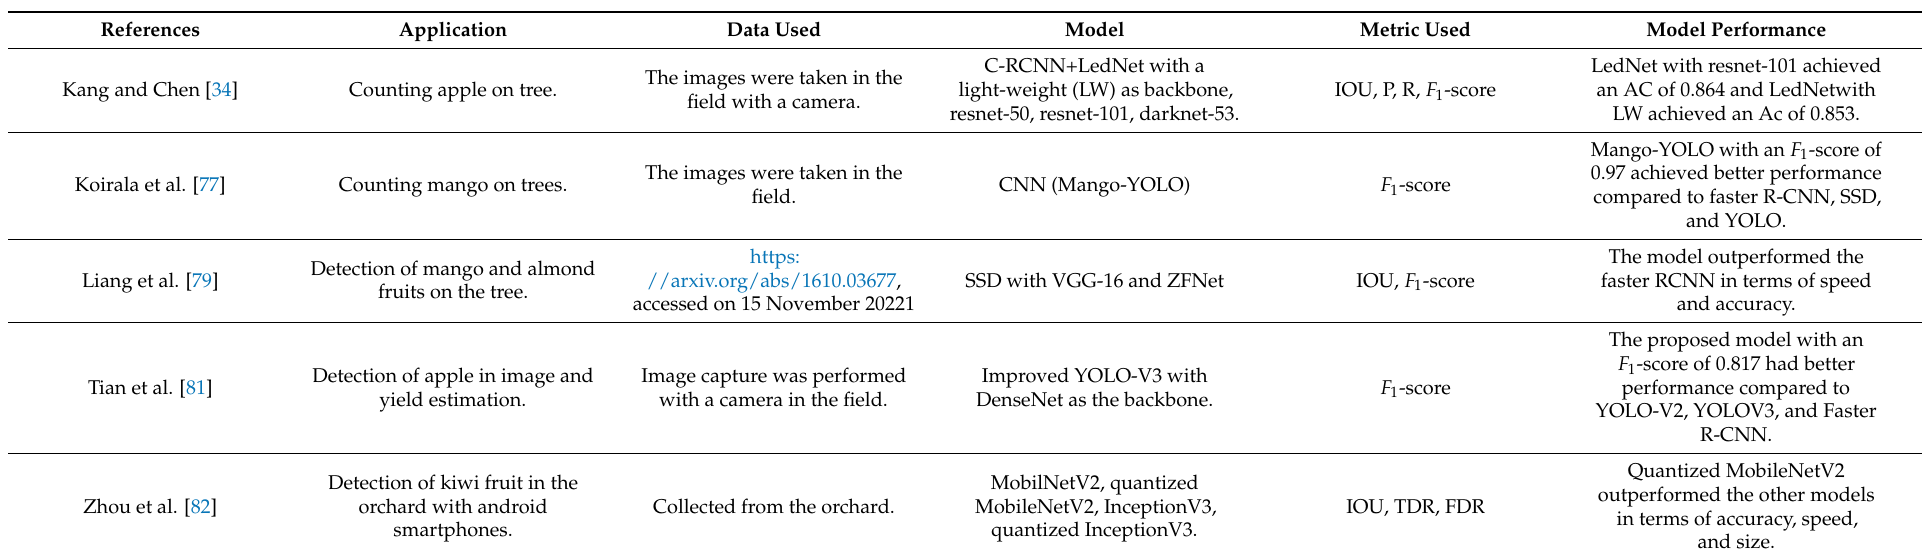
Table 4. Feature descriptions of recent published papers in the field of “Fruit detection and Yield